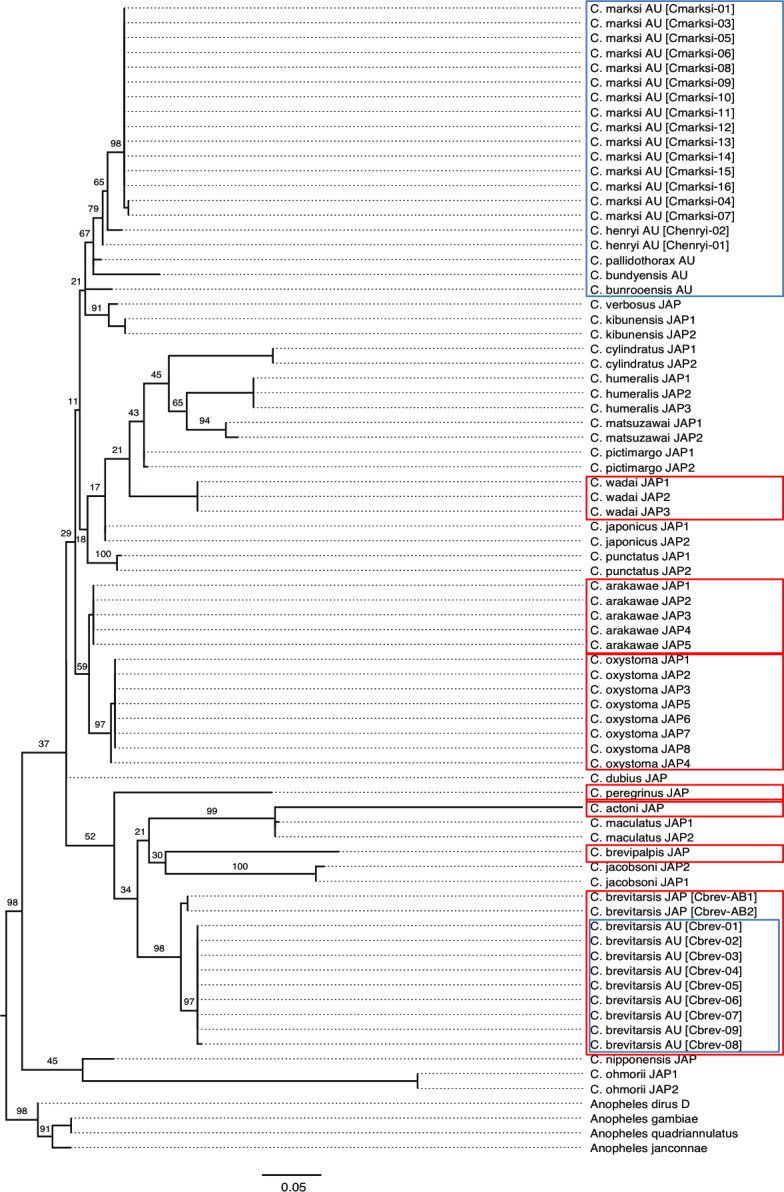
Maximum Likelihood phylogenetic tree including bootstrap values of various Culicoides species from this study.Maximum Likelihood tree, with bootstrap values for some of the internal edges inferred using the UFBoot method. The tree was inferred under the TN+I+G4 model of evolution. Samples are marked using their species name, geographical origin (AU: Australia; JAP: Japan), haplotype name (when available, listed in brackets), and a number (whenever needed, to distinguish some of the sequences). Australian Culicoides are within blue boxes, and known BTV competent Asian/South East Asian Culicoides hosts are in red boxes. The scale bar measures evolutionary distance in terms of average nucleotide substitutions per site. The tree was rooted using four species of Anopheles. The ML tree inferred under the TN+G4 model of evolution differed from this one at seven internal edges, but the overall conclusion remained the same (see text).